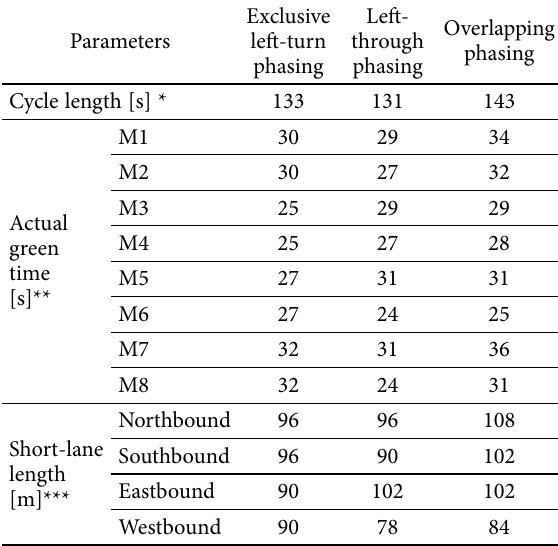
Ascertain the lengths of the short left-turn Ascertain the signal phase plan during the peak